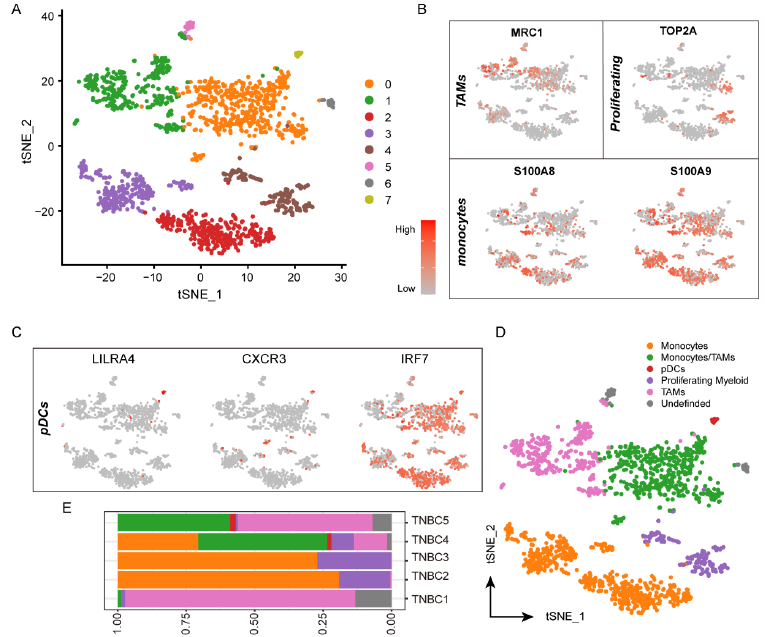
Figure 3. Myeloid-cell subpopulations and gene expression in TNBC. ( A ) t-SNE plot of the myeloid cells in the tumors, color-coded by the associated cell clusters. ( B , C ) t-SNE plot of marker genes for the myeloid-cell subpopulations as indicated, ( B ) TAMs, monocytes, and proliferating, and ( C ) pDCs, the shades of red indicating the gene expression levels. ( D ) t-SNE plot of the myeloid cells in the tumors color-coded by the annotated functional myeloid cells subpopulations. ( E ) Relative proportions of myeloid-cell types for each TNBC patient.